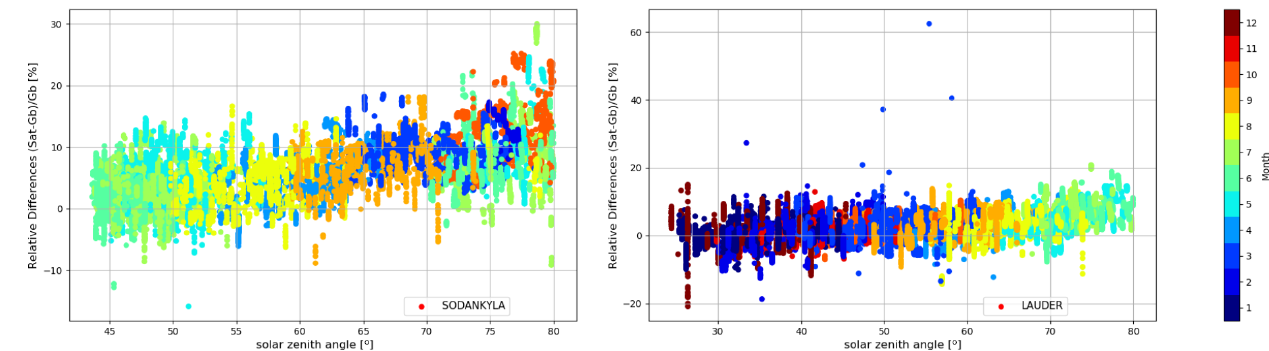
Figure 35. Relative biases between co-located S5P XCO and TCCON unscaled XCO data with a priori aligned are plotted as a function of the S5P measurement solar zenith angles retrieved at a few TCCON stations within the period between November 2017 and September 2020. Spatial co-location with radius of 50km and time of ± 1h around the satellite overpass was used. The colours represent the different months from January (1) until December (12) of a